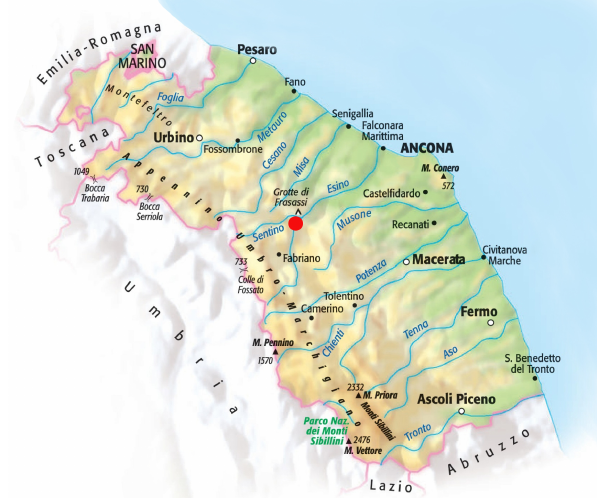
Figure 18. Marche Region, where the red dot indicates the investigated area of the Esino River located in the village of Camponocecchio, municipality of Genga (AN). Table 6. Section of Camponocecchio, Esino River. HEC-RAS model: steady flow analysis, mixed flow regime, boundary conditions (upstream condition: critical depth setting, downstream condition: critical depth setting), and Manning’s roughness coefficient (riverbed = 0.05, floodplains =